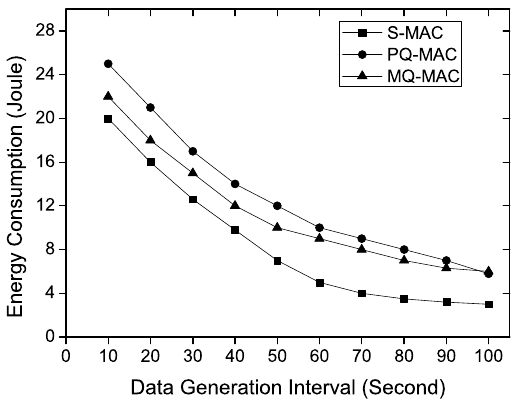
Figure 13. Energy consumption varying data generation